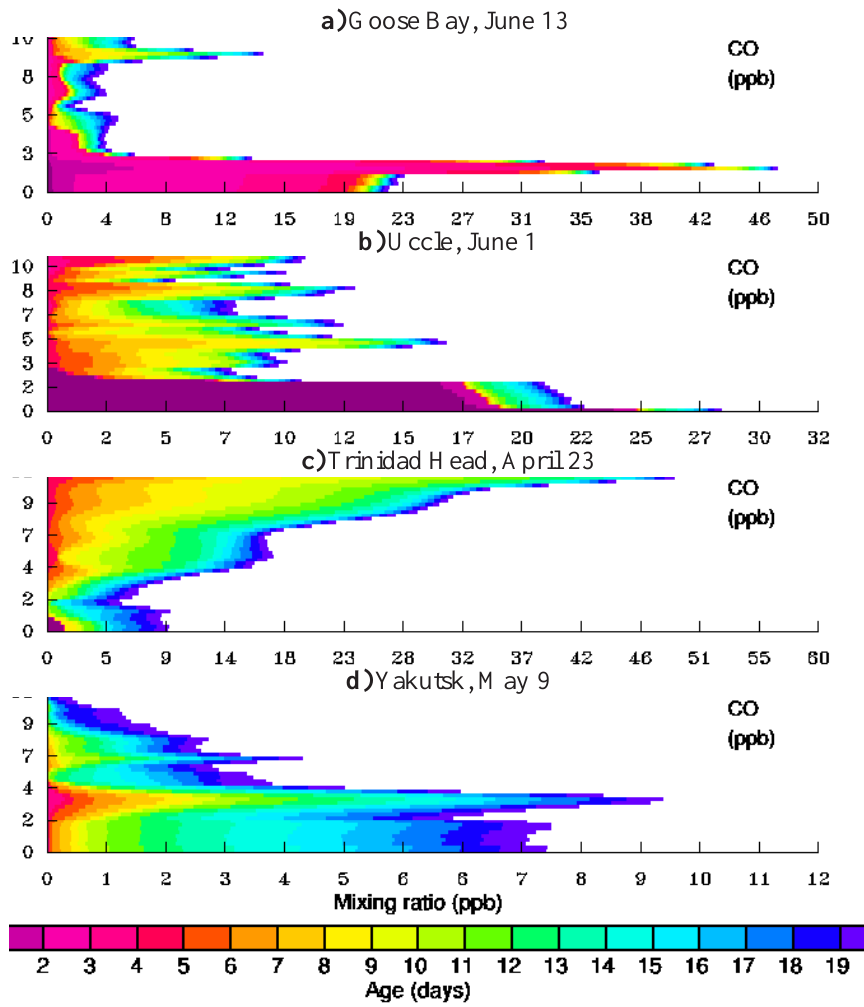
Fig. 16: Age spectrum, showing the enhancement of CO due to emissions over the last 20 days for Goose Bay, Uccle, Trinidad Head and Yakutsk for the same dates as shown in Figures 13 - 15.